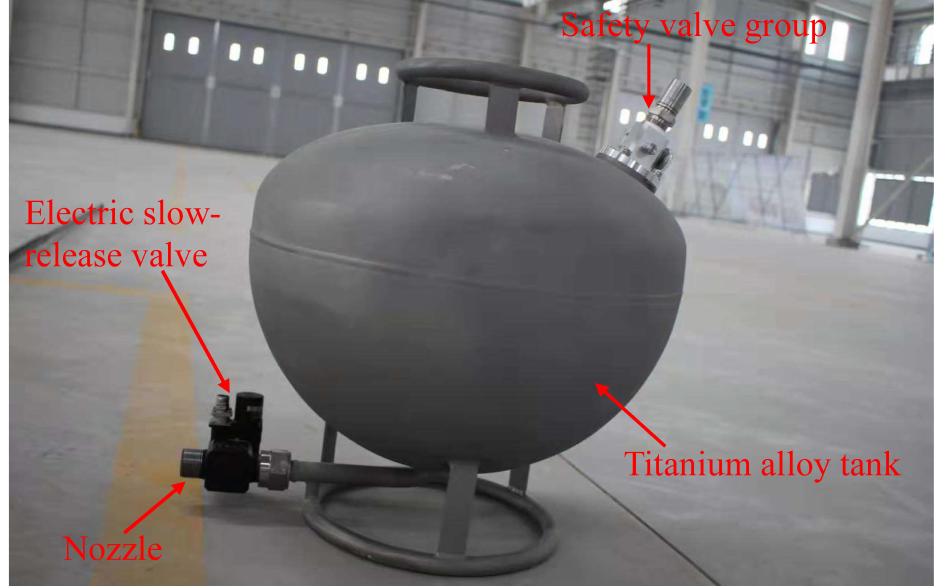
Figure 2. The pressure fire extinguishing